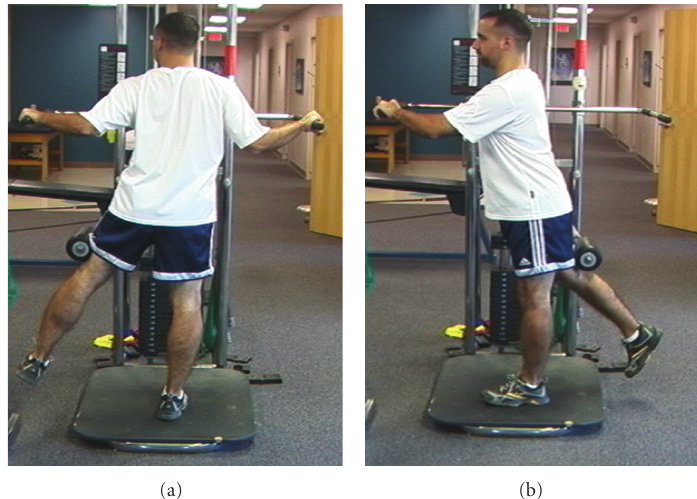
Figure 8: (a) Examples of hip abduction strengthening. (b) Examples of hip extension strengthening.